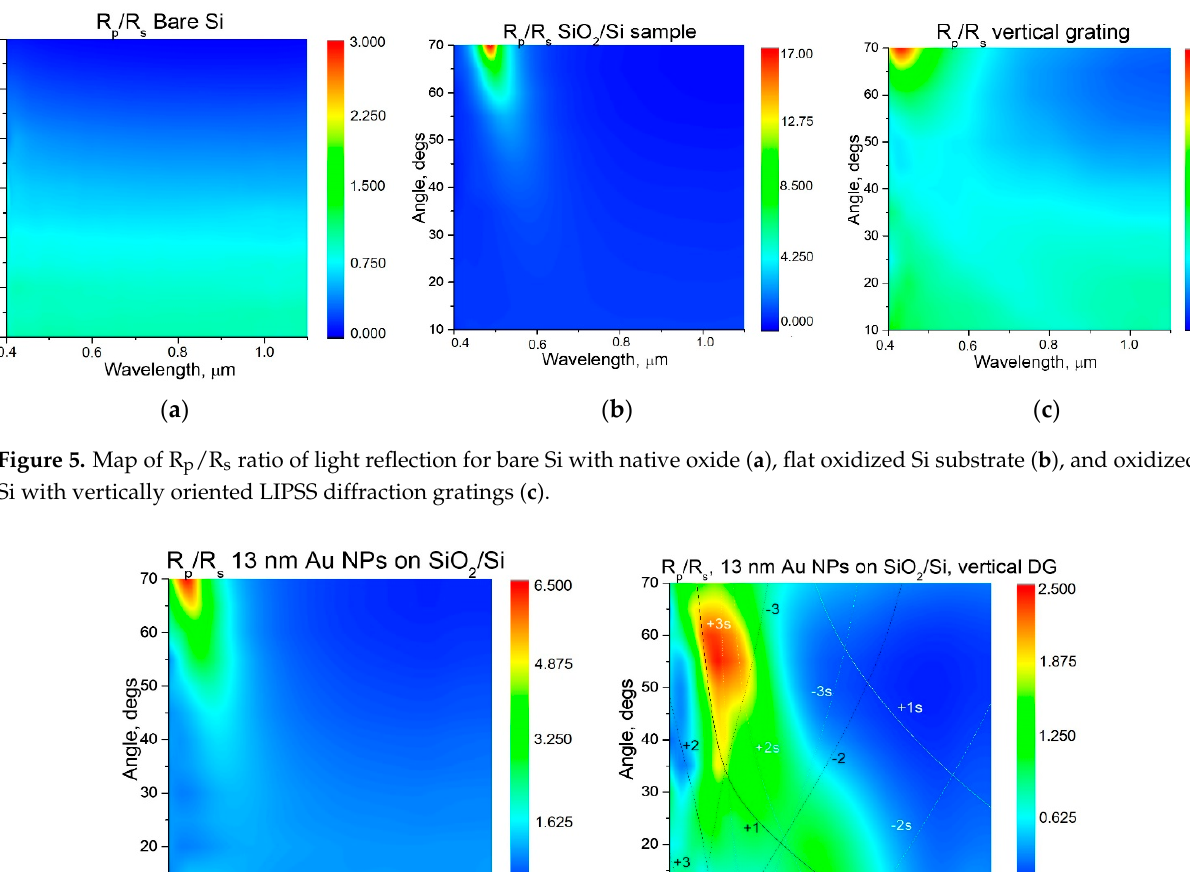
Figure 5. Map of R p /R s ratio of light reflection for bare Si with native oxide ( a ), flat oxidized Si substrate ( b ), and oxidized Si with vertically oriented LIPSS diffraction gratings ( c ).